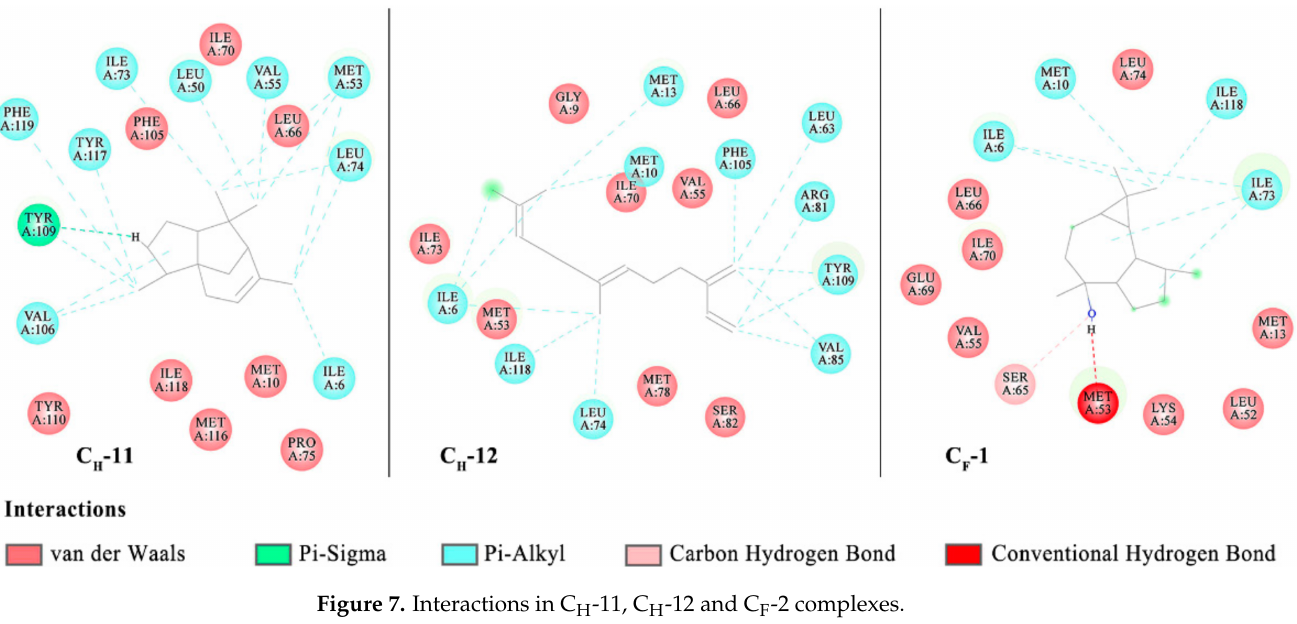
Figure 7. Interactions in C H -11, C H -12 and C F -2 complexes.